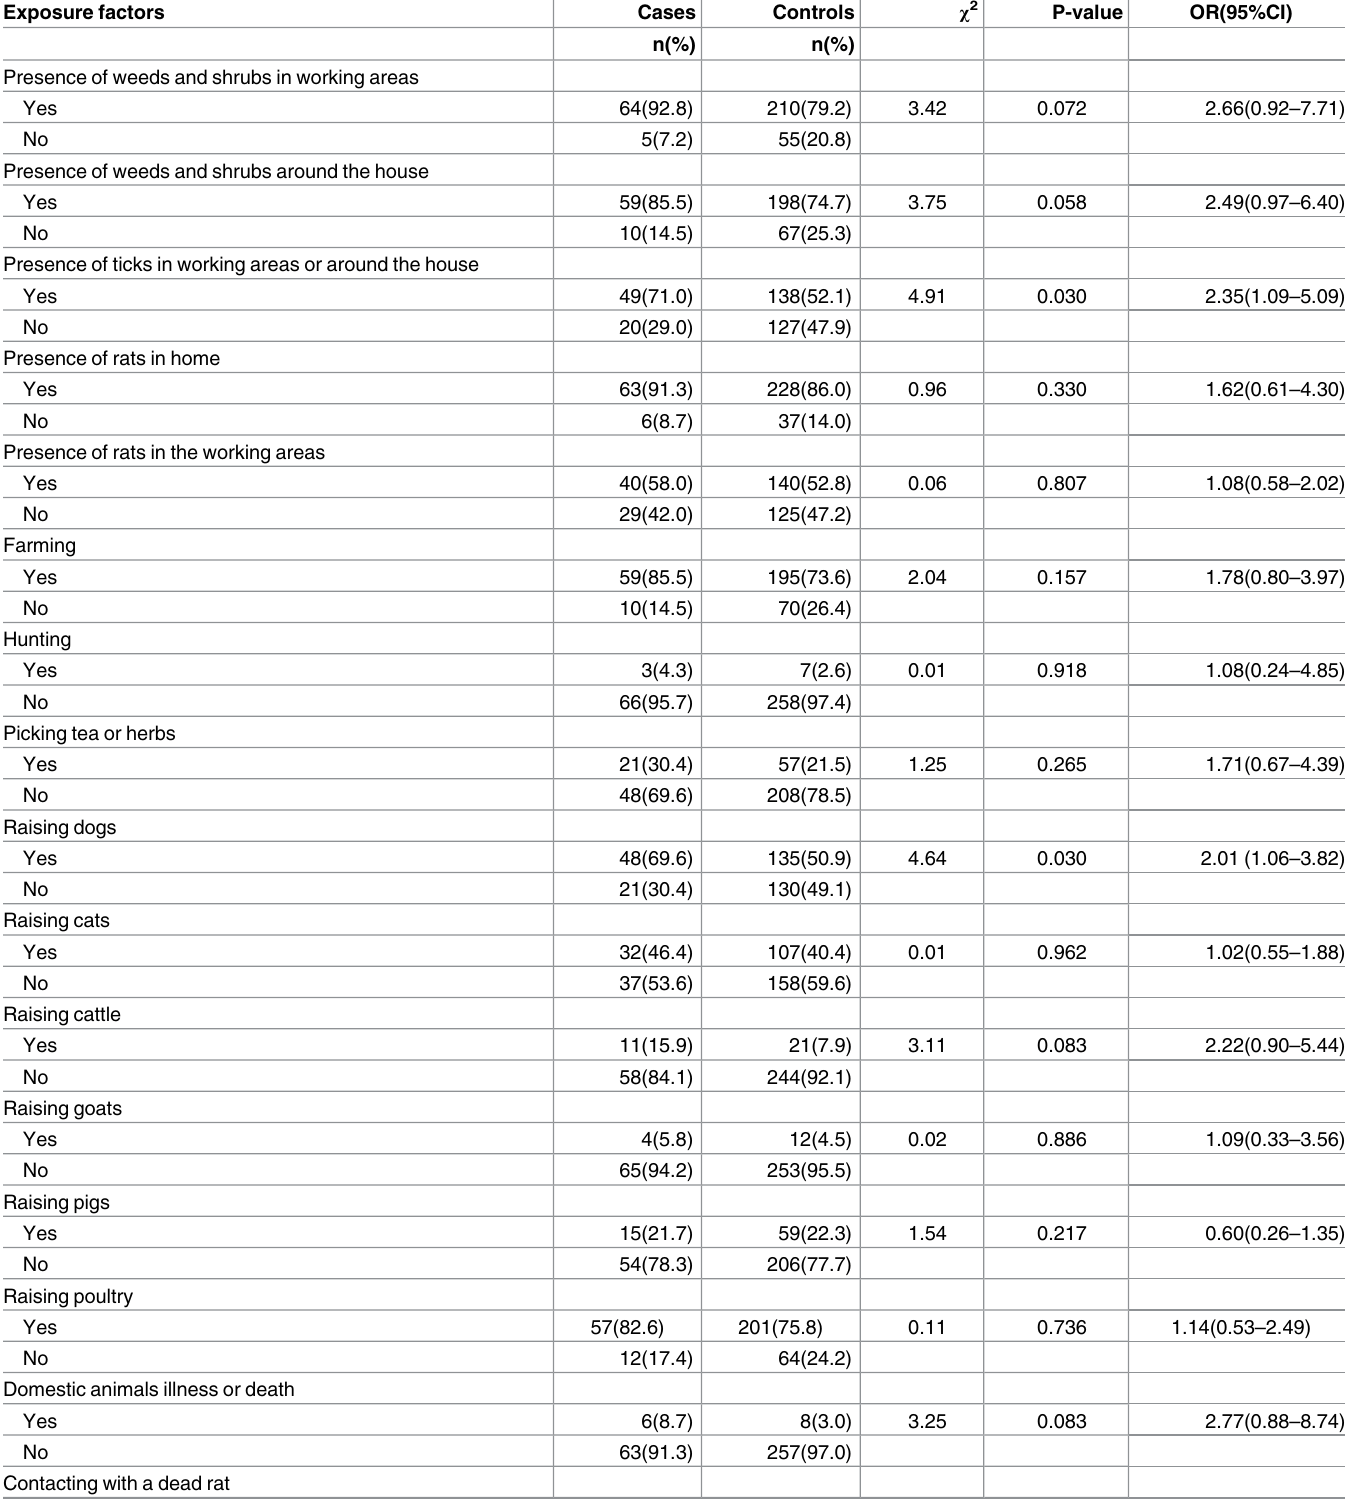
Table 2. Univariate conditional logistic regression analyses of potential risk